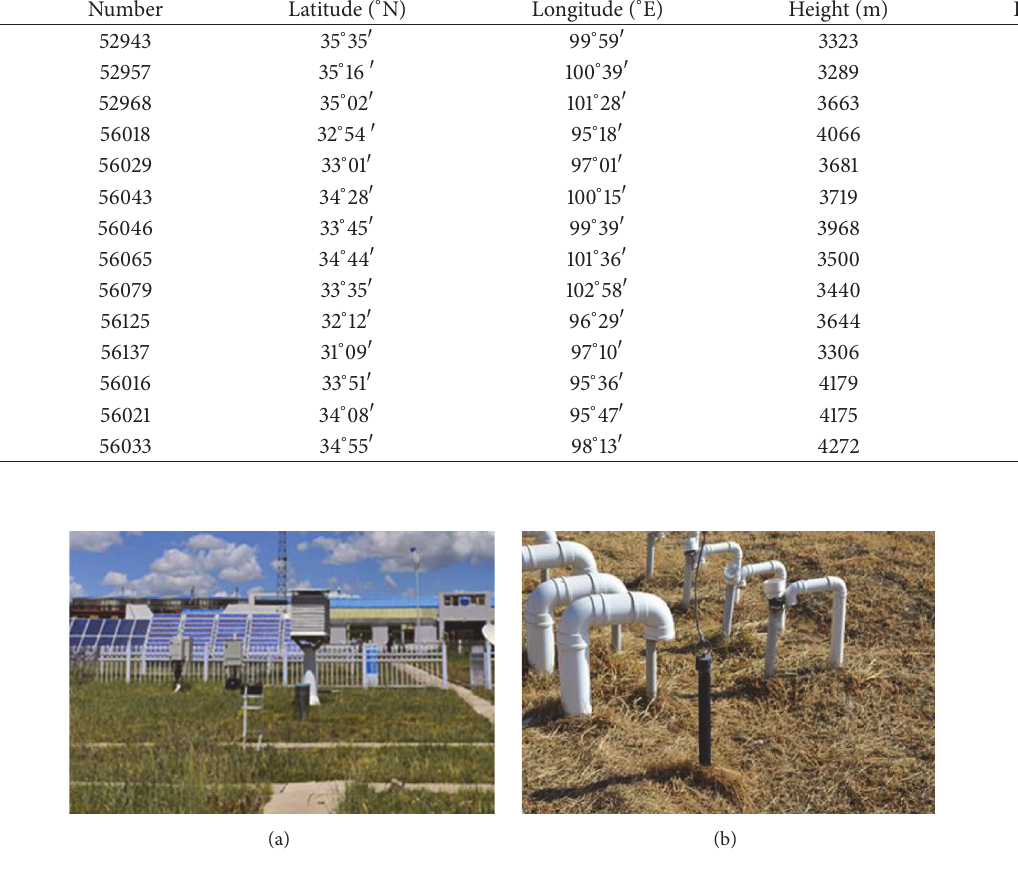
Figure 2: Land cover of observation field in meteorological stations. (a) Summer; (b)